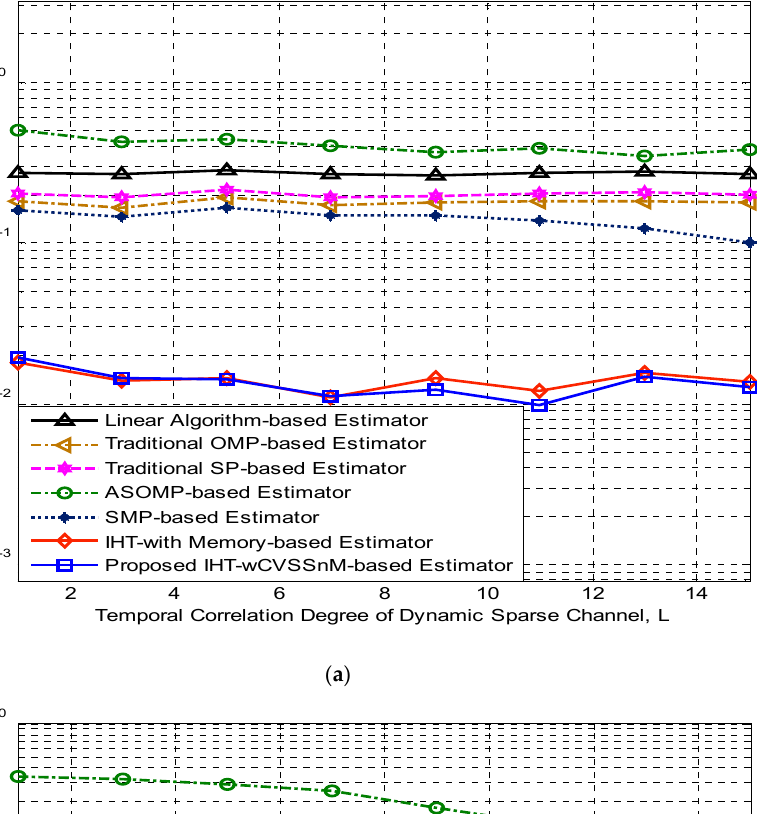
Figure 2. Achievable comparative MSE versus signal to noise ratio (SNR) performance of the proposed IHT-wCVSSnM- based estimator with other channel estimators when the degree of temporal correlation is set as 𝐿 = 8 .